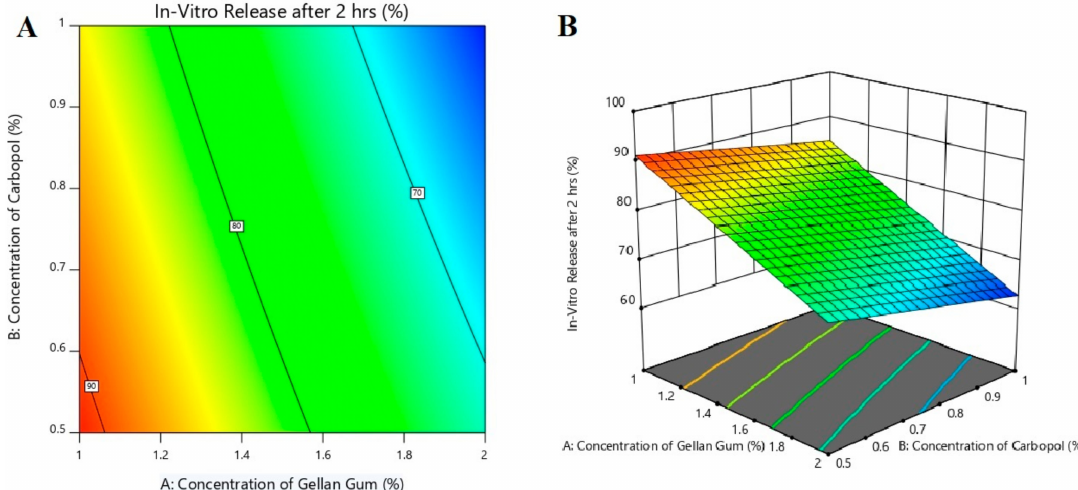
Figure 5. E ff ect of independent variables on in vitro release after 2 h using contour plot ( A ) and 3d surface plot ( B